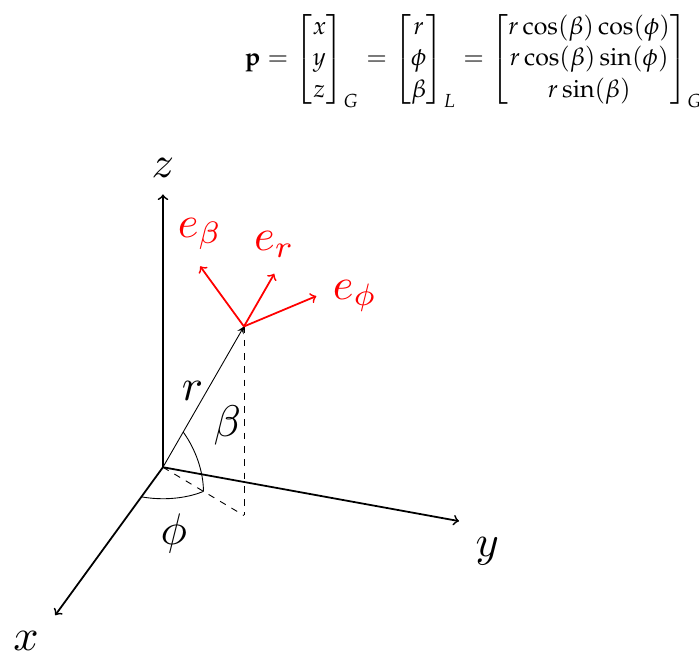
Figure 1. Global and Local Coordinate Systems